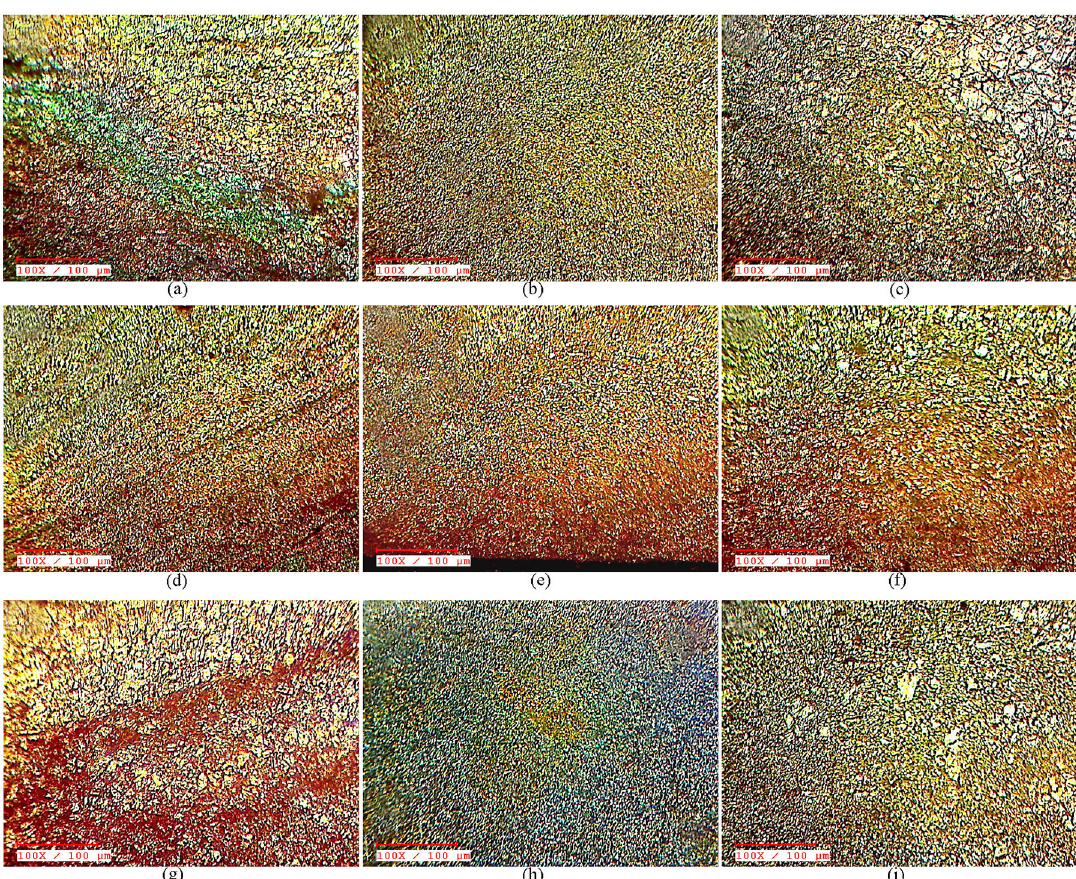
Figure 9. Optical micrographs of various regions of SFSP on Scroll Tool pin